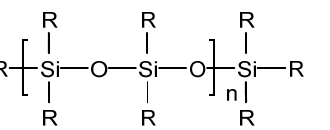
Figure 5. Silicone defoaming agent (R = –CH 3 , the compound is